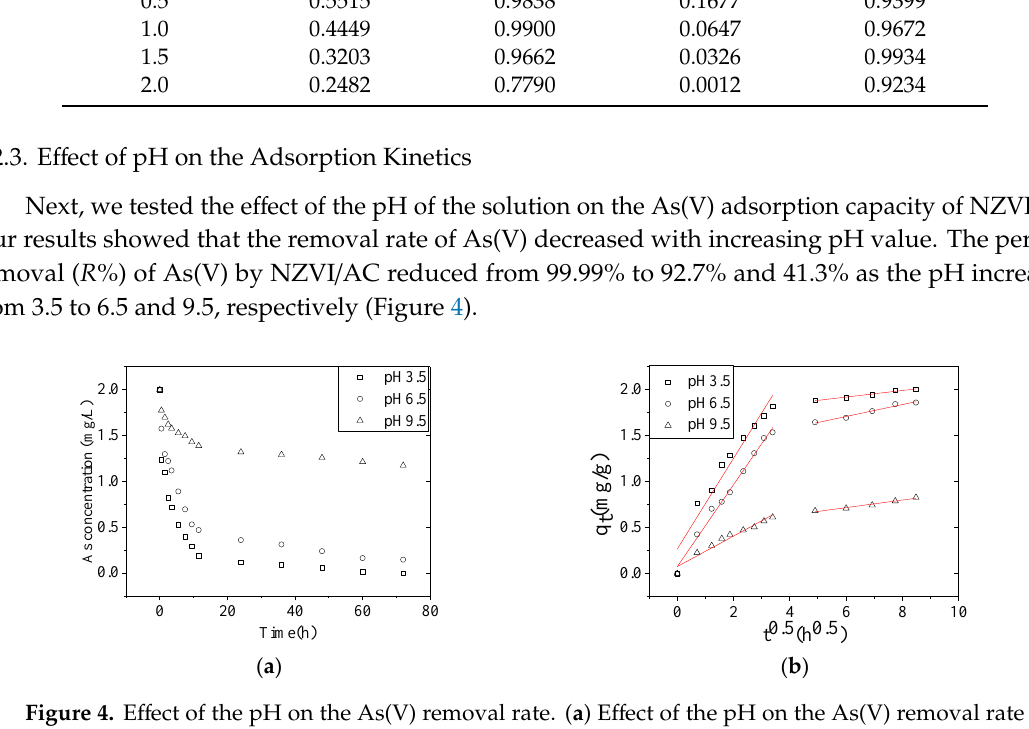
Figure 4. E ff ect of the pH on the As(V) removal rate. ( a ) E ff ect of the pH on the As(V) removal rate Figure 4. Effect of the pH on the As(V) removal rate. ( a ) Effect of the pH on the As(V) removal rate as as a function of time. ( b ) Intraparticle di ff usion model fit for the As (V) removal rate by NZVI / AC at a function of time. ( b ) Intraparticle diffusion model fit for the As (V) removal rate by NZVI/AC at di ff erent pH values (conditions: C 0 = 2.0 mg / L, 150 rpm, 20 × 40 mesh particle size, t = 72 h, T = 298 K, different pH values (conditions: C 0 = 2.0 mg/L, 150 rpm, 20 × 40 mesh particle size, t = 72 h, T = 298 K, adsorbent dosage = 1.5 g / L, pH = 3.5, 6.5, and 9.5). adsorbent dosage = 1.5 g/L, pH = 3.5, 6.5, and 9.5).